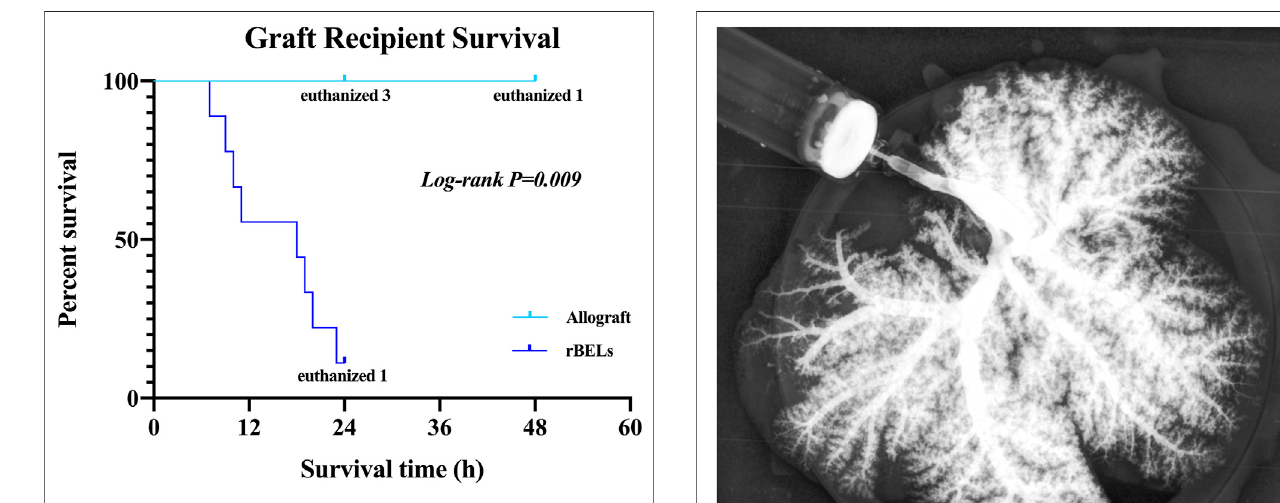
FIGURE 1 | Kaplan-Meier analysis of survival of the allograft group and the rBELs group. Survival rate at 24 h was signi fi cantly higher in the allograft group compared to rBELs group (4 of 4, 100% vs. 1 of 9, 11.1%, p = 0.01). The study endpoint was death or the presence of a death equivalent endpoint. Death equivalent endpoints were: absent graft blood fl ow, grade IV hepatic encephalopathy, and uncontrolled bleeding, and animals were euthanized.